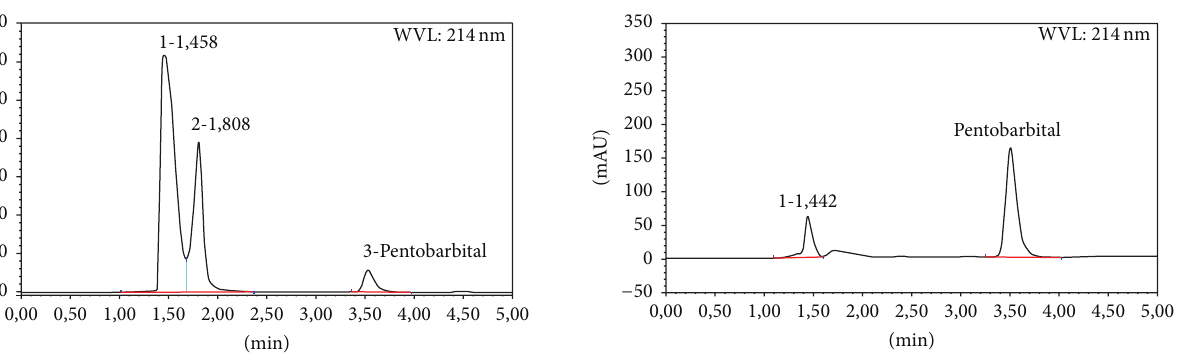
Figure 2: Chromatogram of 12 N NaOH treated pentobarbital so- dium at 50 ∘ C for 48h.